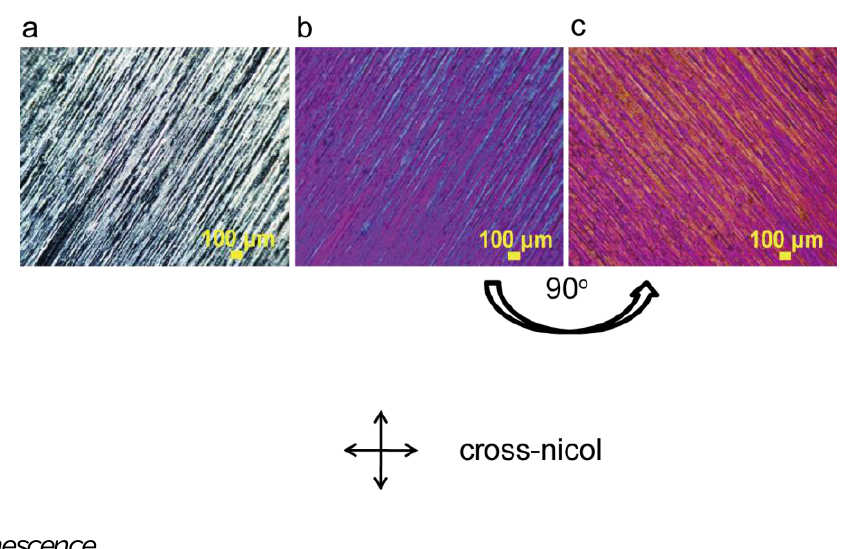
Figure 4. Crossed-polarizing optical microscope images of Poly(3,4-BAHBA- co -4HCA)s with a 4HCA composition of 75 mol%. ( a–c ) The sample was sheared to 250 °C and then supercooled to room temperature. ( b , c ) The image was taken under a first-order retardation plate (λ = 530 nm). ( b ) was rotated 90° to obtain ( c